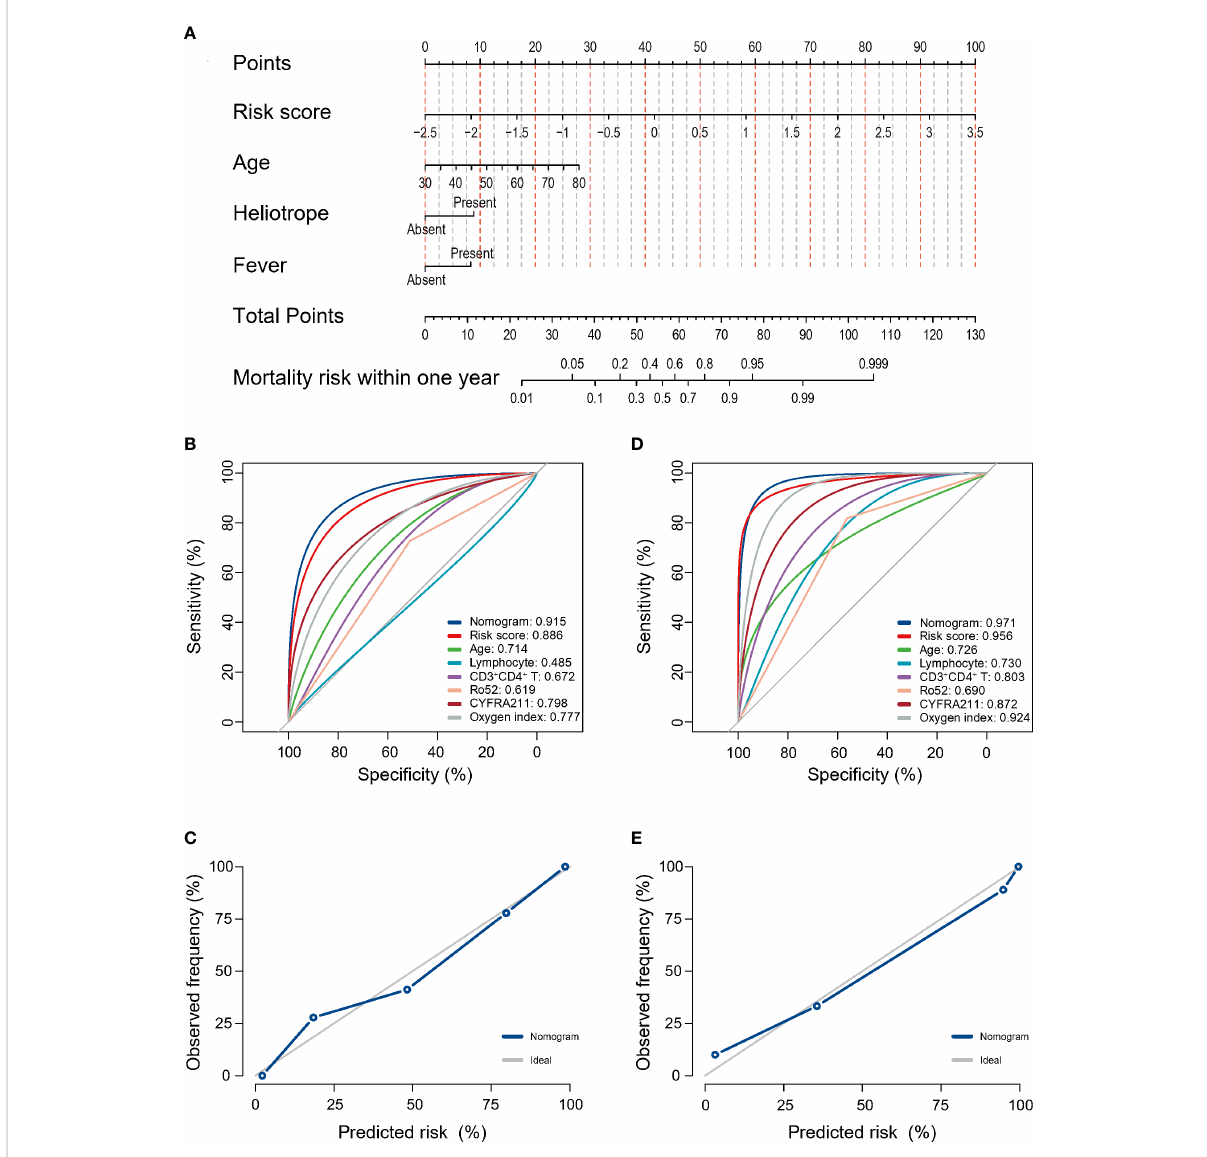
FIGURE 3 The prediction model of mortality risk for patients with anti-melanoma differentiation-associated gene 5 antibody-positive dermatomyositis with interstitial lung disease was visualized as a nomogram (A) . The discrimination was assessed by the area under the receiver operating characteristic (AUC) curves for the prediction model and other indicators in the discovery cohort (B) and temporal validation cohort (C) . Calibration was assessed using observed vs. predicted graphs in the discovery cohort (D) and temporal validation cohort (E)